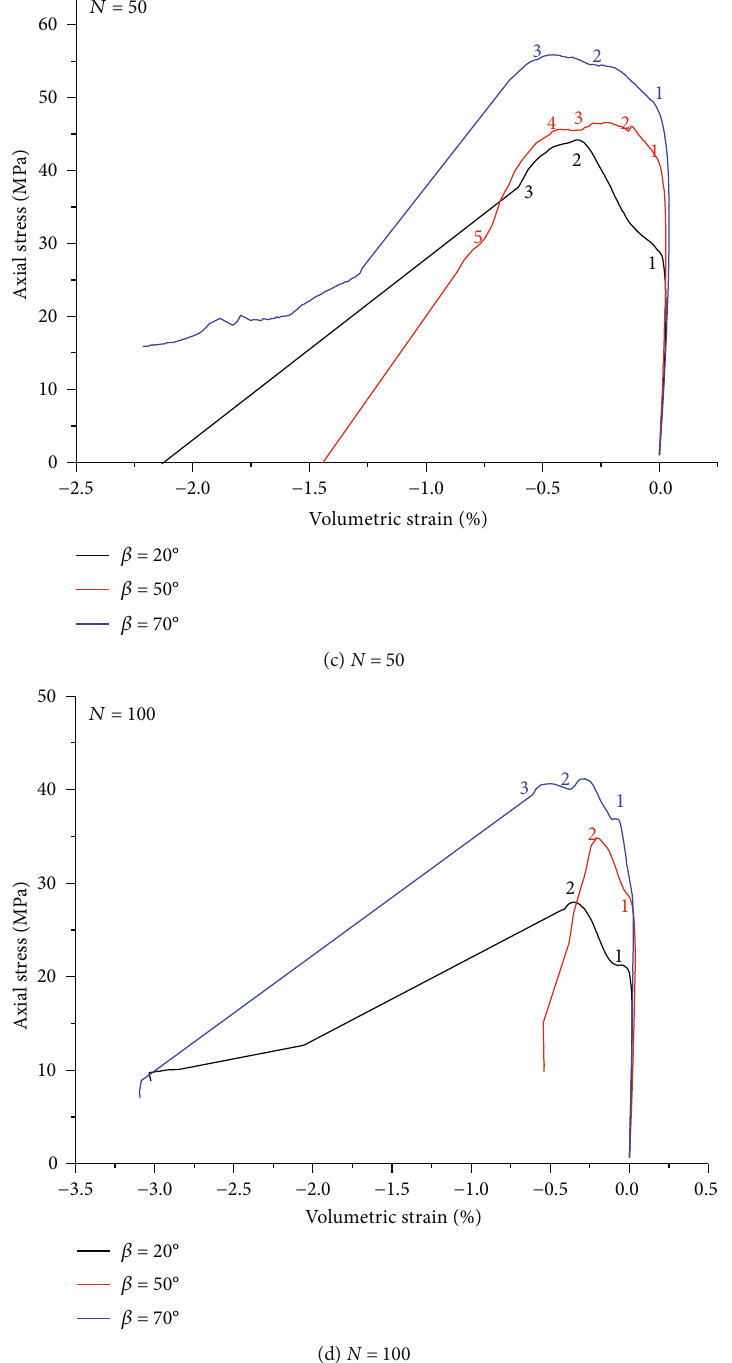
Figure 8: The typical volumetric stress – strain curves for the samples containing two fl aws. (a – d) The number of F-T cycles is 0, 20, 50, and 70,